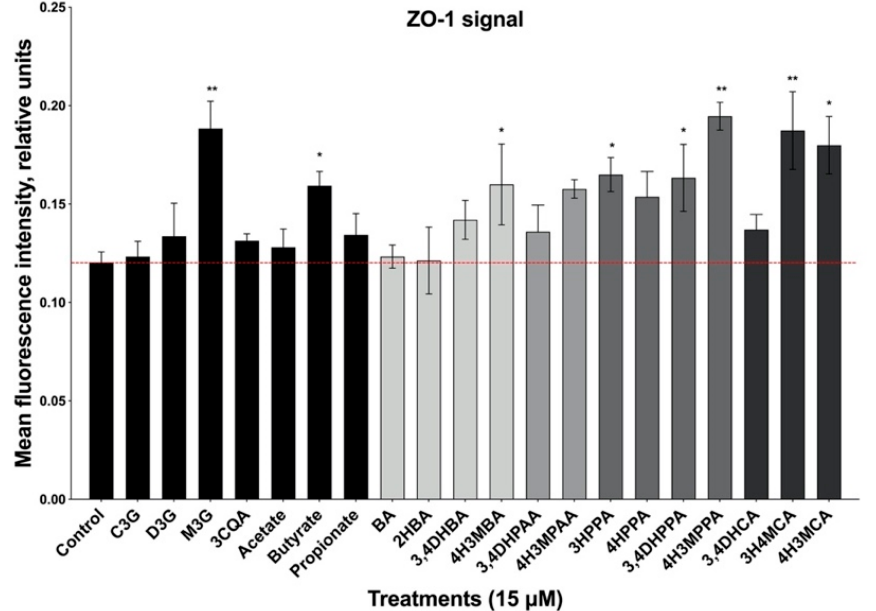
Figure 3. Effects of wild blueberry anthocyanins, short-chain fatty acids, and phenolic acid metabolites on the formation of junctional complexes in the CCD-18 gastrointestinal cells monolayers. Cells were allowed to form monolayers for 5 days with/without the indicated treatments and compared against vehicle control (0.1% DMSO). Zonulin accumulation in the junction complexes was visualized using ZO-1/TJP1 antibody Alexa Fluor 488, mean fluorescent intensity at 490 nm excitation/525 nm emission and reported as mean ± SEM (* p < 0.05, ** p < 0.01).